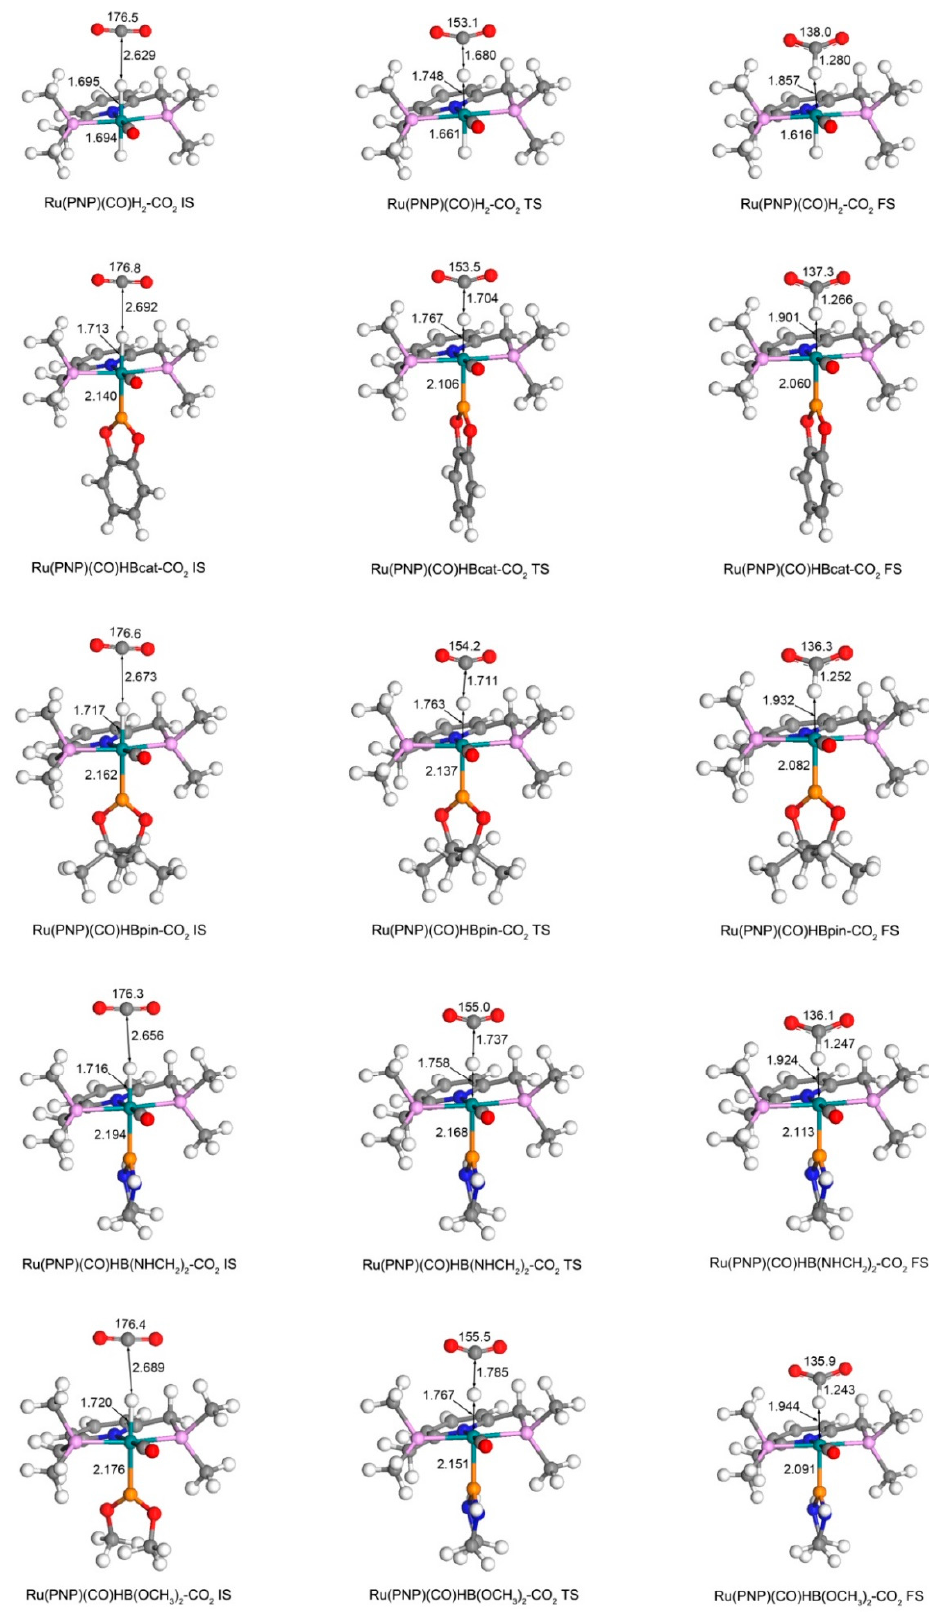
Figure 2. Optimized geometries of the species involved in the addition of hydride to CO 2 on selected Ru PNP-type complexes. Bond distances are given in angstrom (Å) and bond angles are in degree (°) (green balls: Ru; violet: P; red: O; blue: N; grey: C; orange: B; white: H).